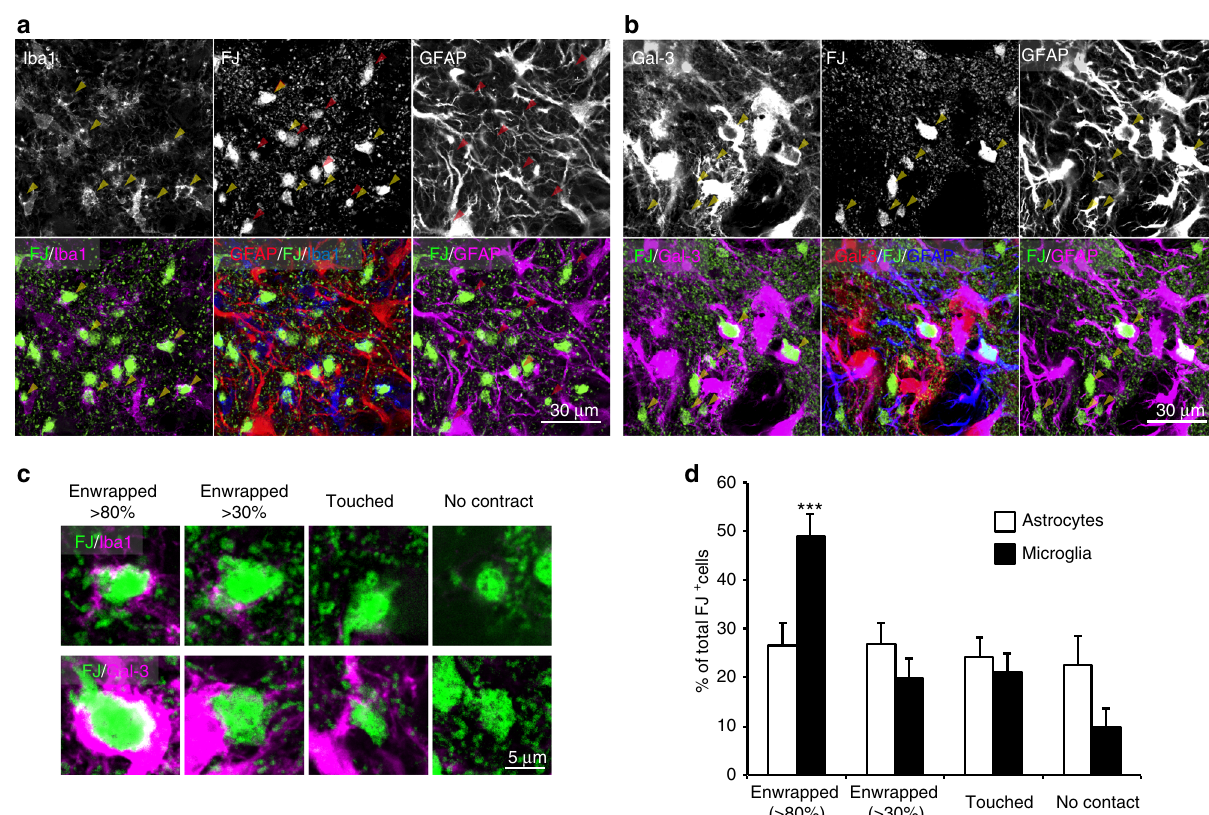
Fig. 3 Comparison of enwrapped neuronal debris by astrocytes and microglia. a Representative images showing immunohistochemical (IHC) staining for GFAP, and Iba1 with FJ staining in the ischemic penumbra at 7 days after MCAO. Iba1 + microglia ( yellow arrowheads ) and GFAP + astrocytes ( red arrowheads ) enwrapped FJ + large neuronal debris by their processes. b Representative images showing IHC staining for Galectin-3 and GFAP with FJ staining in the ischemic penumbra at 7 days after MCAO. Galectin-3 and GFAP double-positive processes enwrapped FJ + large neuronal debris (yellow arrowheads). c Representative images showing quanti fi cation of the amount of FJ + large debris (size over 10 µ m 2 ) enwrapped by Iba1 + microglia or Galectin-3 + , GFAP + astrocytes. d Quanti fi cation of FJ+ large debris enwrapment by Iba1 + microglia and Galectin-3 + , GFAP + astrocytes ( n = 13 fi elds, four mice, *** P < 0.001 vs. astrocytes). All images are single plane